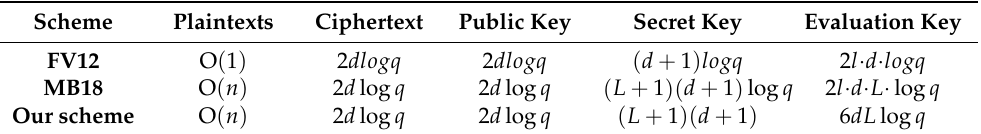
Table 2. A scheme parameter size